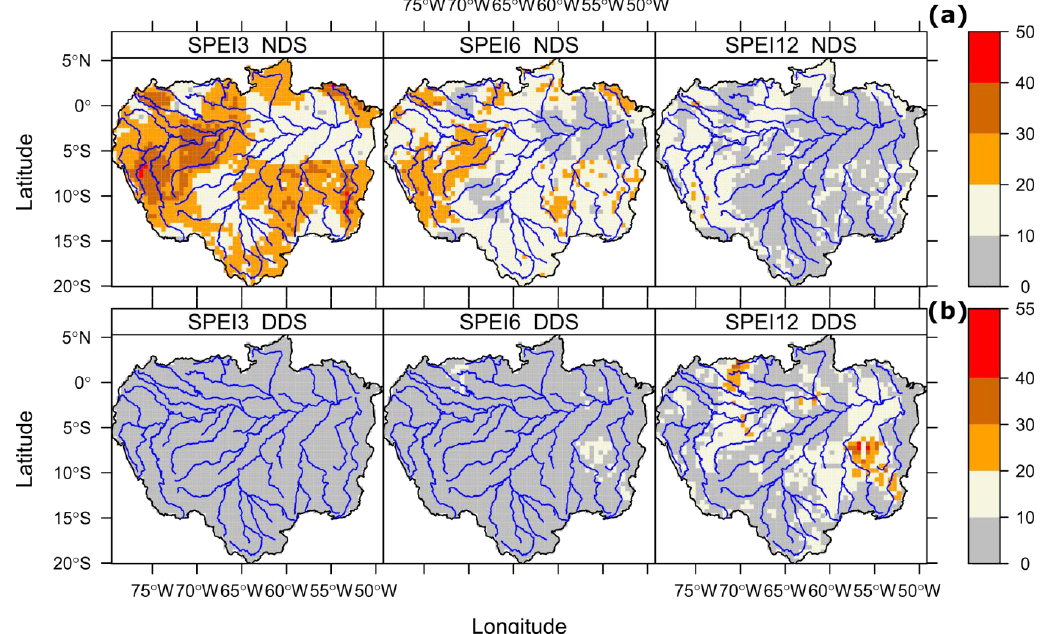
Figure 9. The spatial distribution during 1975–2018 of ( a ) the number of dry spells [NDS] based on the SPEI3, SPEI6, and SPEI12, respectively; ( b ) the average duration of the dry spells [DDS] based on the SPEI3, SPEI6, and SPEI12, respectively. The average duration of the dry spells is shown in months.